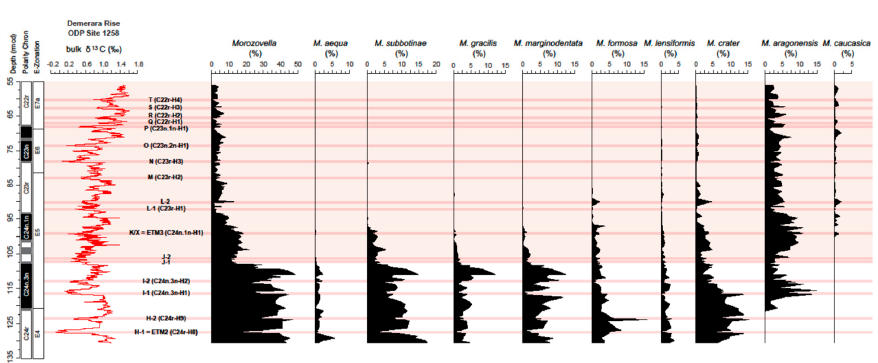
Figure 4. Bulk sediment δ 13 C curve across the early Eocene interval at ODP Site 1258 along with relative abundances of the Morozovella species plotted vs depth. Note that the major permanent decline in Morozovella occurring slightly below the J CIE mainly happens because of reductions in all morozovellid species with the exception of M. aragonensis that ranges up to the middle Eocene [38]. Other information is the same as in previous figures.